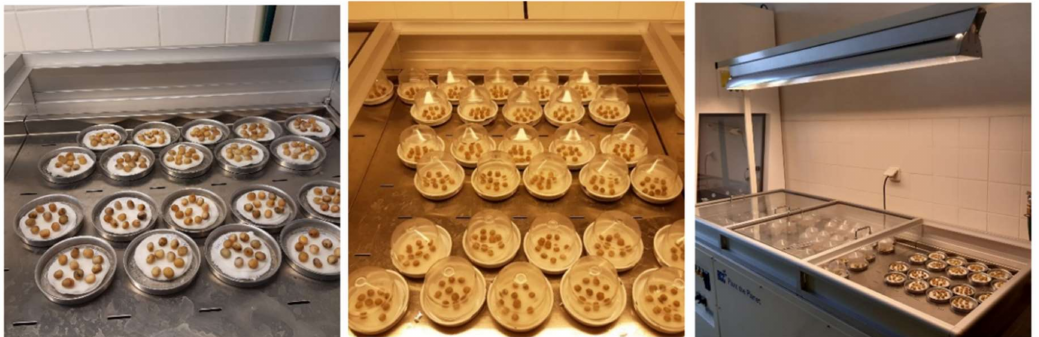
Figure 2. Photographs showing the seeds of D. steudneri in a Petri dish with germination media (photo on the left ), the seeds covered by cups inside the Jacobsen germinator (photo in the middle ) and the partial view of the Jacobsen germinator (photo on the right